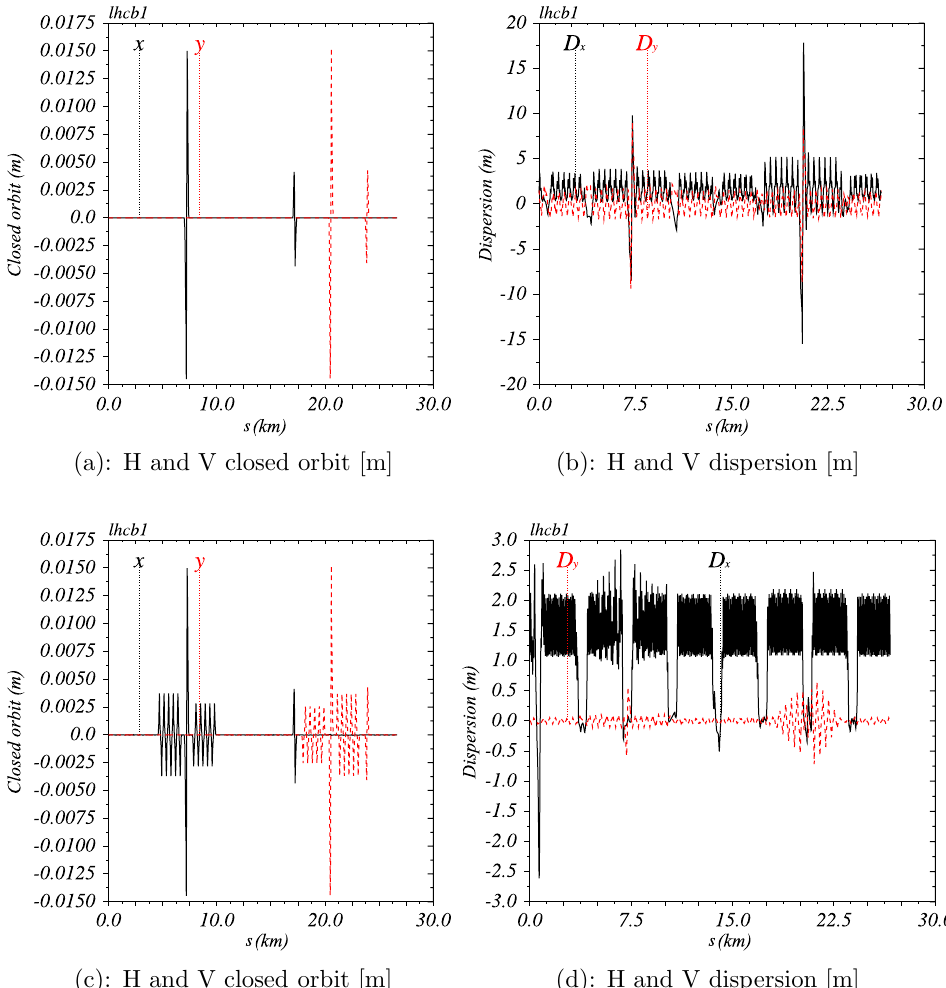
FIG. 11. Horizontal and vertical closed orbit (left pictures) and dispersion (right pictures) around the LHC ring for the round ATS optics considered in Fig. 9(a) with (cid:1) (cid:1) ¼ 10 cm and a crossing angle of 720 (cid:3) rad . The machine is cycled from IP3 for the clockwise rotating Beam1. The highest orbit excursions shown in (a) result from the crossing angles at IP5 (horizontal) and IP1 (vertical), while the smaller peaks on either side of the second highest peak are due to the H and V crossing angles at IP8 and IP2, respectively. The dispersion is fully mismatched in the first case (top pictures). In the second case (bottom picture), horizontal (respectively vertical) orbit bumps are generated in the arcs 45 and 56 (respectively 81 and 12), reducing the dispersion mismatch by more than 1 order of magnitude [note the change of vertical scale between (b) and